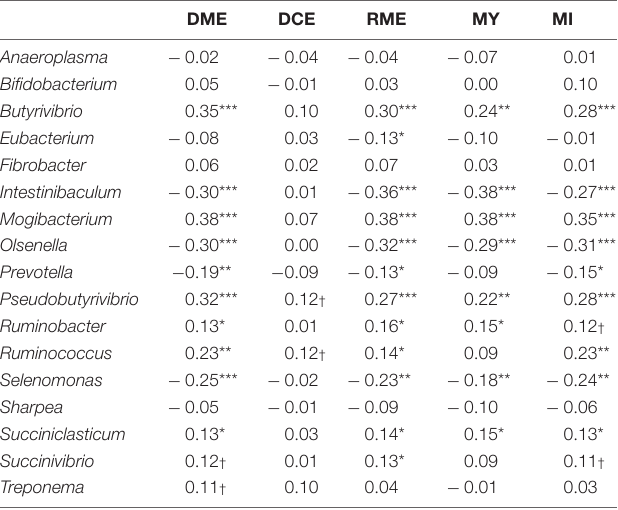
TABLE 2 | Correlation coefficients amongst rumen bacterial genera and traits associated with enteric